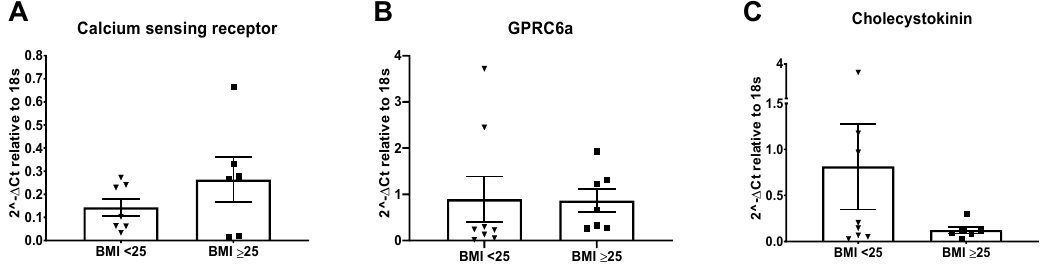
Figure 4. Relative mRNA expression of nutrient receptors in colonic tissue from a UK cohort. Relative expression (against 18s) of ( A ) CaSR ( n = 7; n = 6), ( B ) GPRC6a ( n = 8; n = 7) and ( C ) cholecystokinin ( n = 8; n = 6) in a cohort of patients from the Royal London Hospital, divided into those with a BMI < 25 and BMI ≥ 25, respectively.